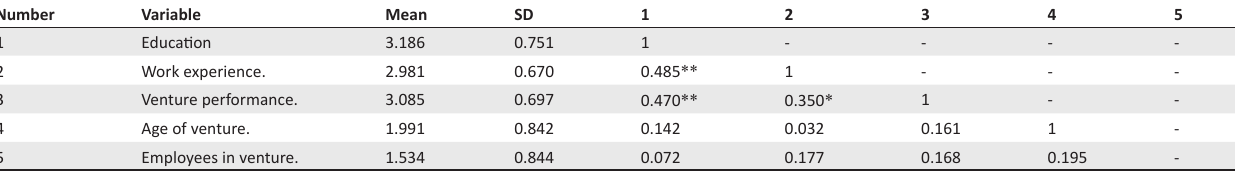
TABLE 2: Sample characteristics per cluster. Variable Types of retailing.